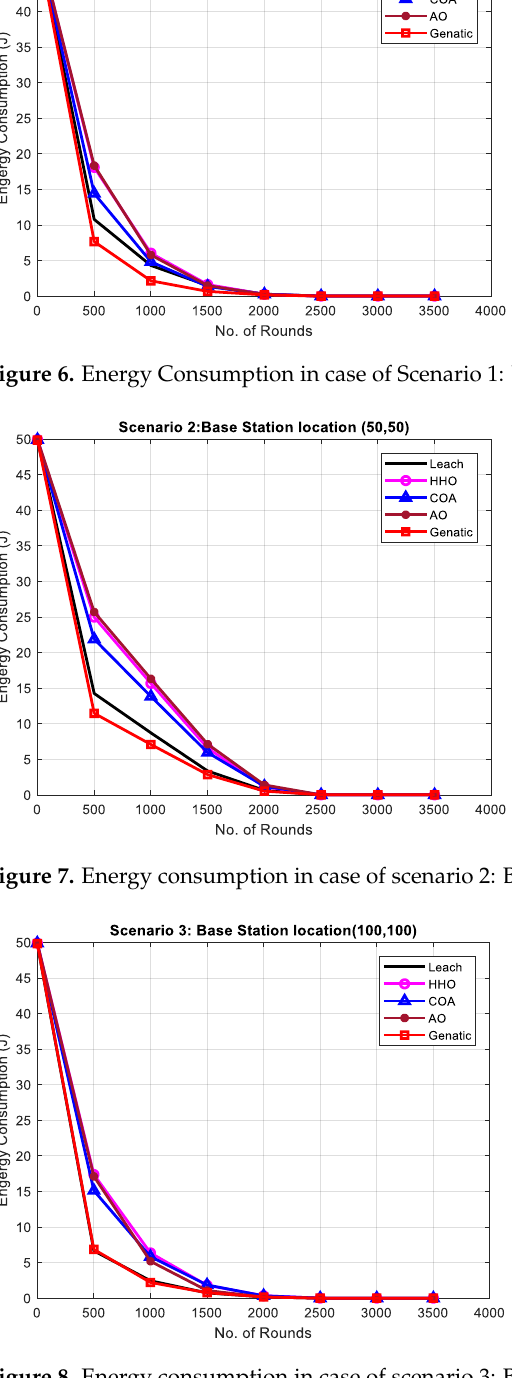
Figure 8. Energy consumption in case of scenario 3: BS at (100,100).